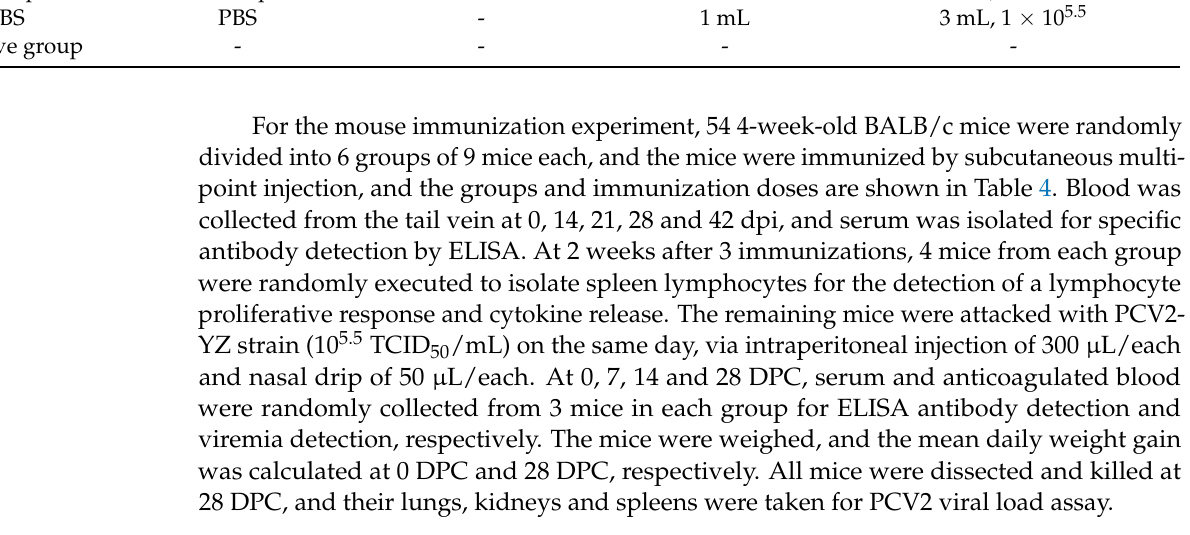
Table 4. The vaccination and challenge status for